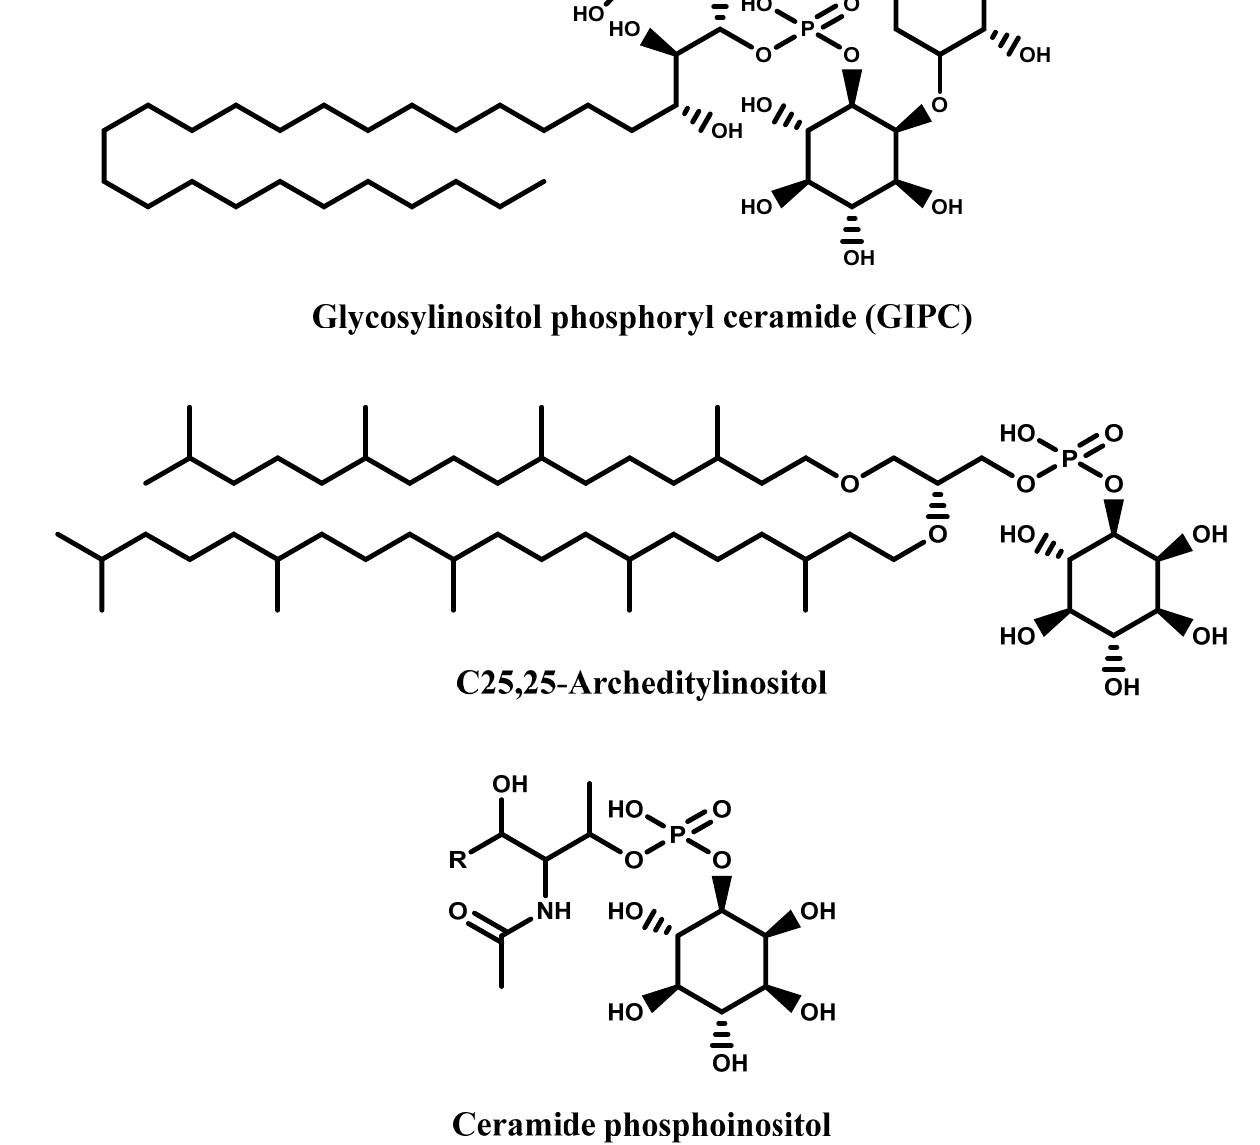
Figure 4. Examples of inositol ceramides, sphingolipids and